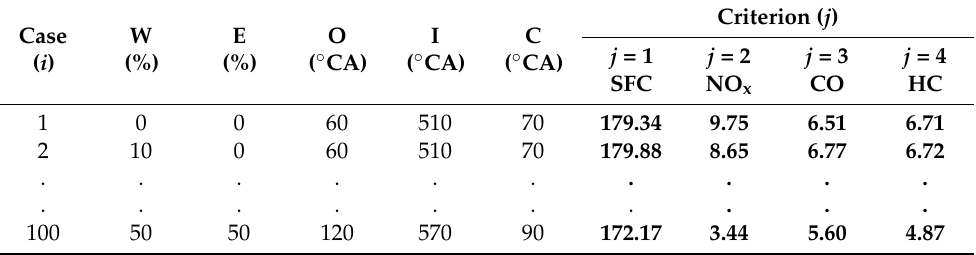
Table 1. Decision